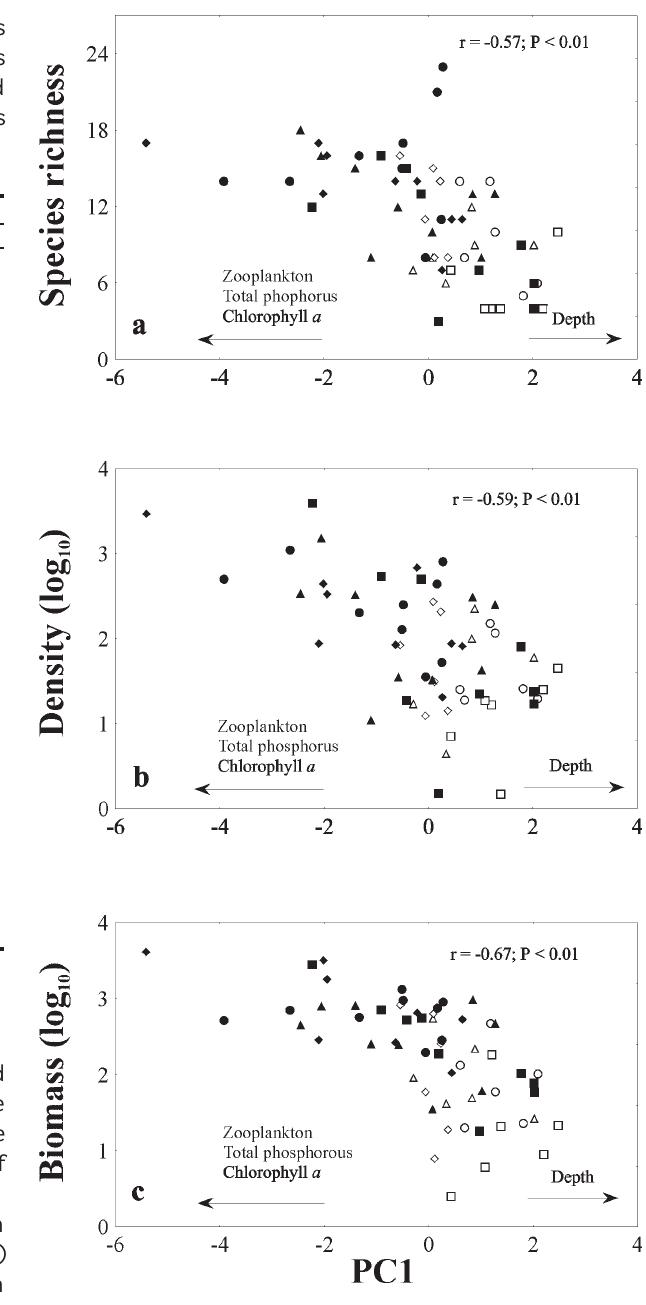
Fig. 5. Correlation between PCA axis 1 and species richness (a), density (b), and biomass (c) in connected [February ( ), May ( ), August ( ), November ( )] and disconnected lagoons [February ( ), May ( ), August ( ), November ( )]. Arrows indicate the direction of the limnological